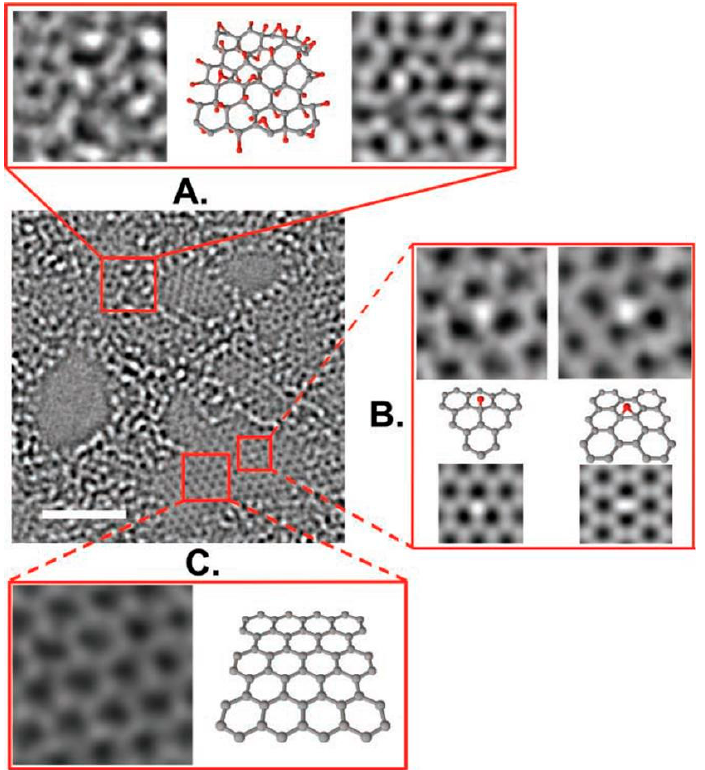
Figure 3. Aberration-corrected TEM image of a single sheet of suspended GO. The scale bar is 2 nm. Expansion ( a ) shows, from left to right, a 1-nm 2 enlarged oxidized region of the material, then the proposed possible atomic structure of this region with carbon atoms in gray and oxygen atoms in red, and finally the average of a simulated TEM image of the proposed structure and a simulated TEM image of another structure where the position of oxidative functionalities has been changed. Expansion ( b ) focuses on the white spot on the graphitic region. This spot moved along the graphitic region, but remained stationary for 3 frames (6 s) at a hydroxyl position (left portion of expansion ( b )) and for 7 frames (14 s) at a (1,2) epoxy position (right portion of expansion ( b )). The ball-and-stick figures below the microscopy images represent the proposed atomic structure for such functionalities. The simulated TEM image for the suggested structure agrees well with the TEM data. Expansion ( c ) shows a 1 nm 2 graphitic portion from the exit plane wave reconstruction of the focal series of GO and the atomic structure of this region. Reproduced with permission [57] .